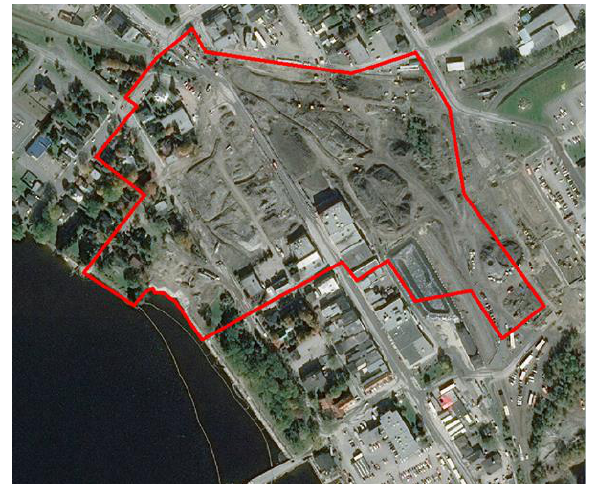
Figure 11. Pléiades image acquired on September 30, 2013 shows evidence of large quantities of fresh soil being stockpiled. © CNES 2013, Distribution Airbus DS